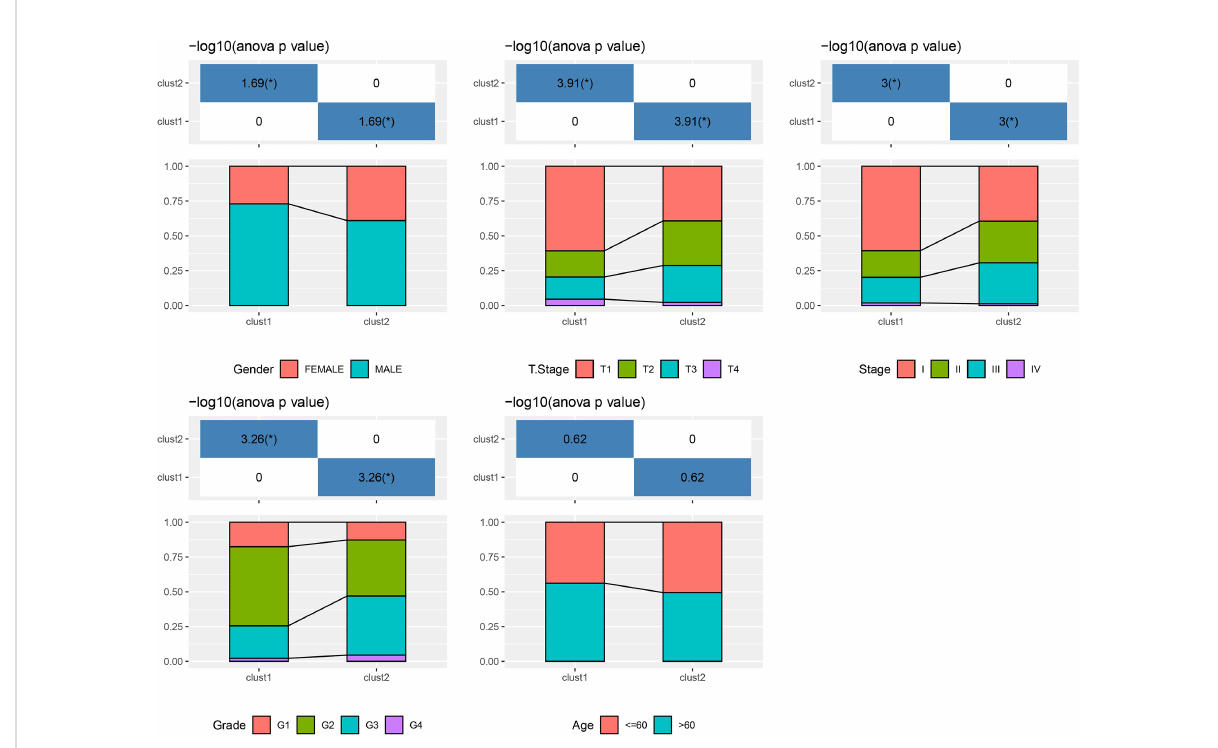
FIGURE 4 The distribution of clinical features, including gender, T stage, stage, grade and age, in Clust1 and